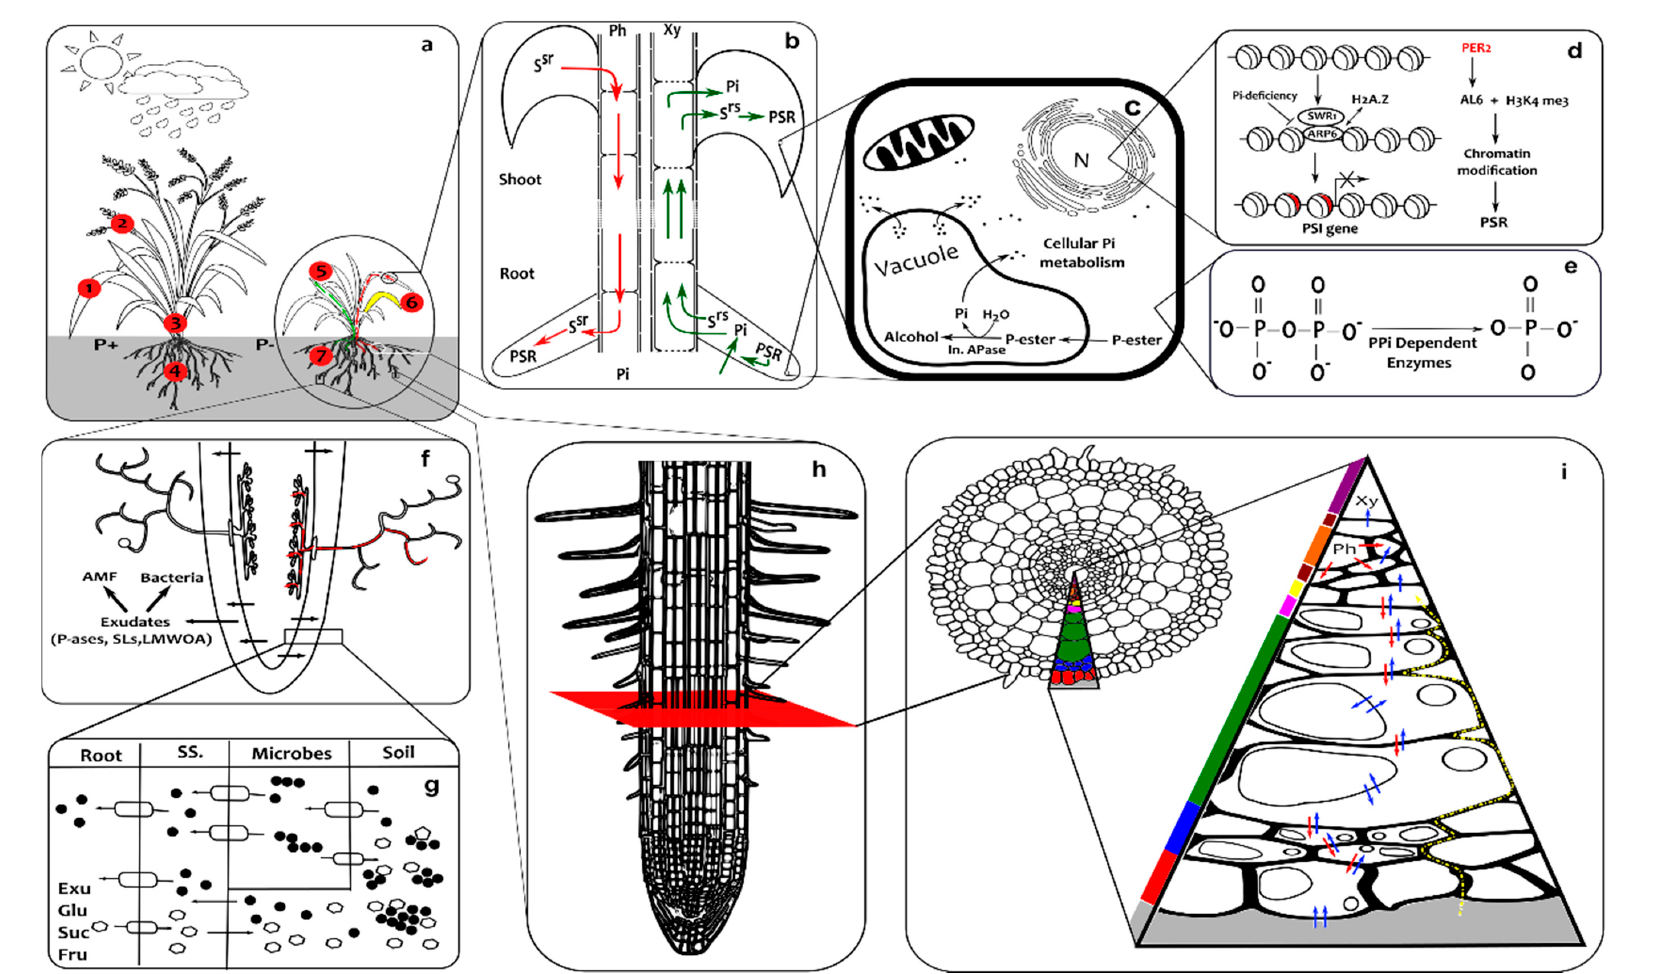
Figure 1. Integrated overview of phosphate starvation responses. The responses and signalling mechanisms operate at a range of scales and different locations which are depicted in nine connected panels: ( a ) denotes the whole plant and field scale; the numbers in red circles represent normal and low inorganic phosphate conditions (1) phosphorus playing a major role in various plant growth and developmental process including photosynthesis; (2) the highest level of Pi being found in